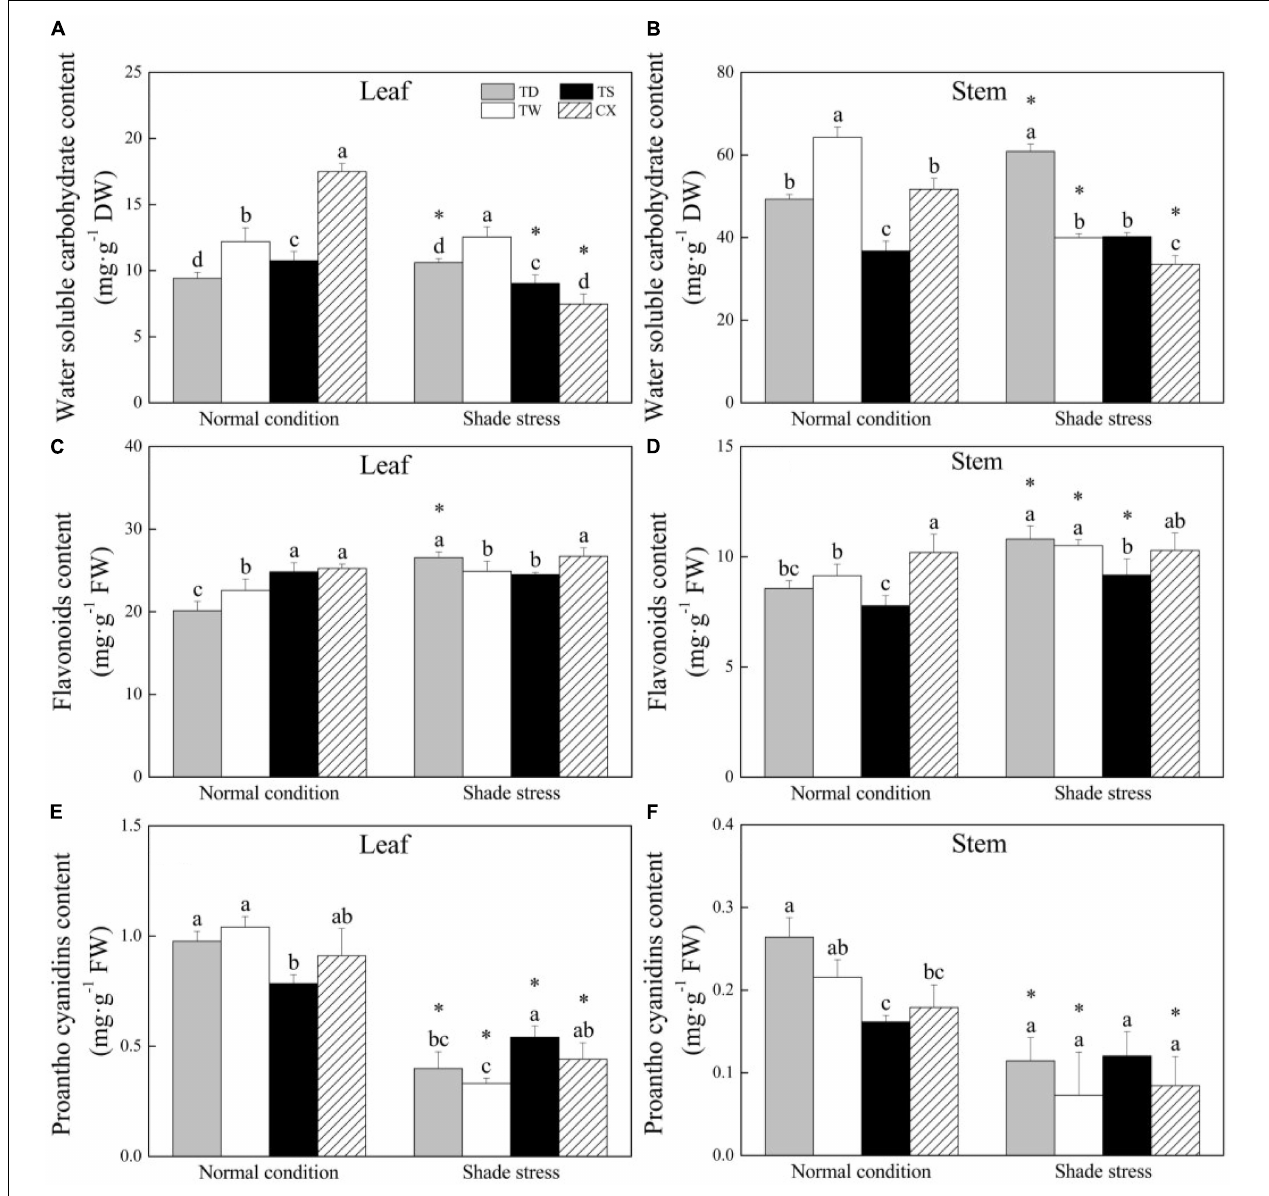
FIGURE 5 | Effects of shade stress on (A) water-soluble carbohydrate content in leaf, (B) water-soluble carbohydrate content in stem, (C) flavonoids content in leaf, (D) flavonoids content in stem, and (E) proantho cyanidims content in leaf, and (F) proantho cyanidims content in stem of four bermudagrass cultivars. Vertical bars indicate the ± SE of mean ( n = 4). Different letters above columns indicate significant differences ( p ≤ 0.05) among the four cultivars under normal conditions or shade stress. The asterisk ( ∗ ) above letter indicates a significant difference ( p ≤ 0.05) in one particular cultivar between normal conditions and shade